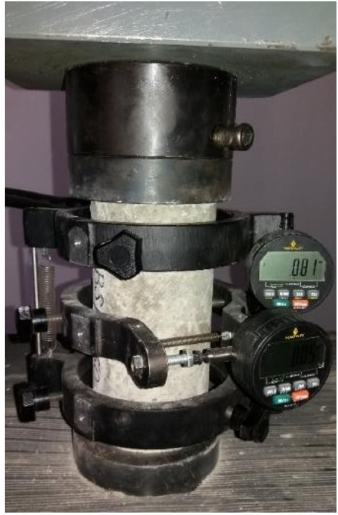
Figure 6. Modulus of elasticity